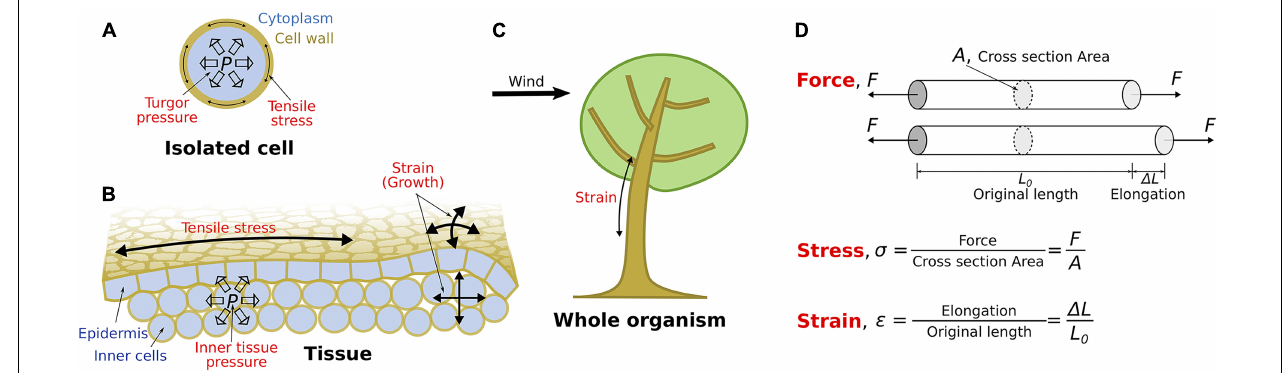
FIGURE 1 | Mechanical signals and physical quantities. (A–C) Schematic representation of common occurrences of stress and strain as sources of mechanical signals at the cell (A) , tissue (B) , and whole organism level (C) . (A) At the single cell level, turgor pressure from the cytoplasm leads to tensile stress in the cell wall. (B) At the tissue level (here epidermis and two inner cell layers), inner tissue pressure may lead to tensile stress and growth in the epidermis. (C) At the whole organism level (here a tree exposed to wind), external forces can induce significant strain. (D) Schematic and mathematical representation of the notions of force, stress and strain. Forces (F) are represented as vectors applied in opposite directions at both ends of the object. Stress ( σ ) is the ratio of the force (F) to the cross-sectional area (A) of the object on which the force is applied. Strain ( ε ) is the ratio of the elongation of the object ( (cid:49) L ) to its original length (L 0 ) .